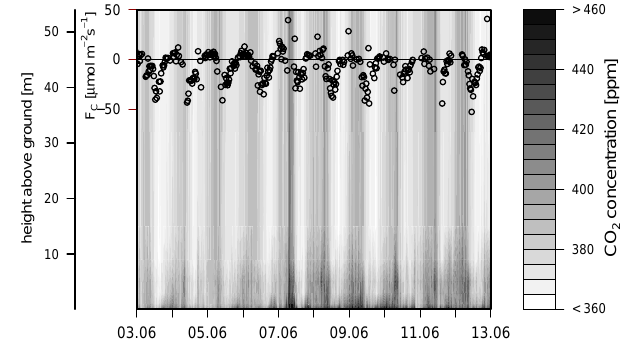
Fig. 6. Vertical profile of CO 2 concentrations and CO 2 flux during ten days in June 2007. The inset with open circles shows the net CO 2 flux measured by EC (30-min averages). Mean canopy height is 30m.